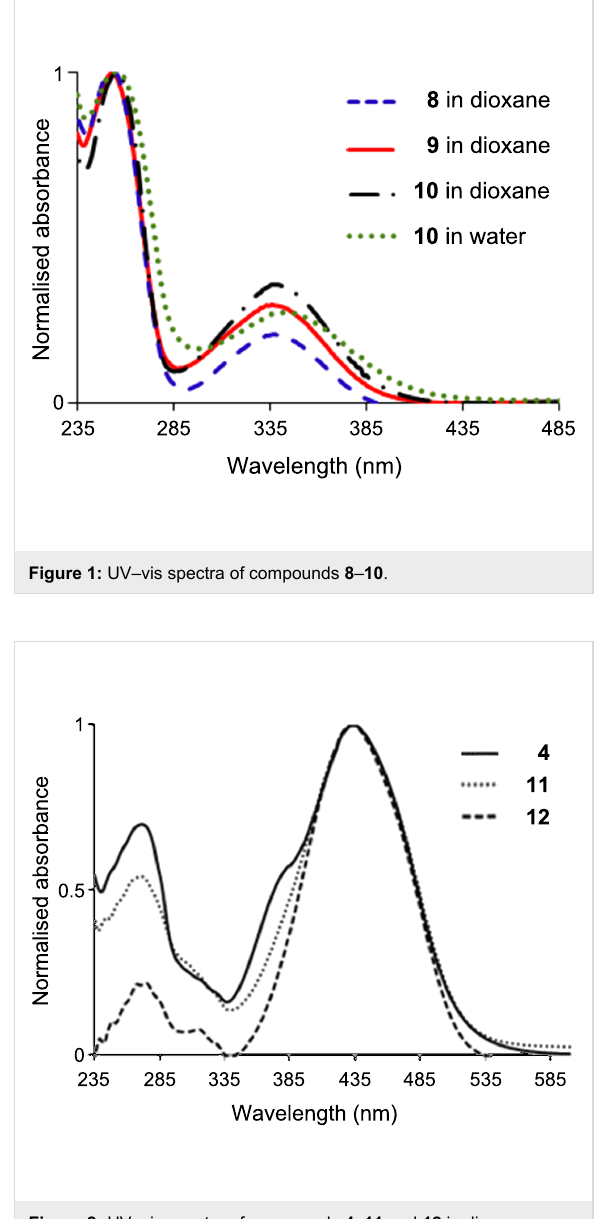
Figure 2: UV–vis spectra of compounds 4 , 11 and 12 in dioxane.